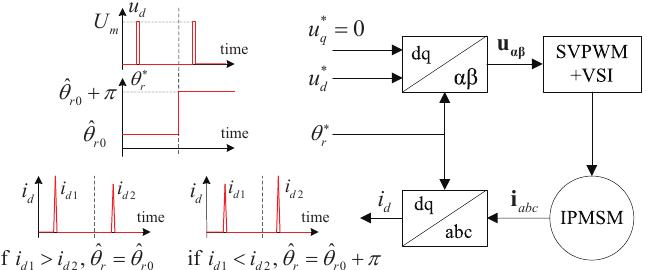
Figure 4. Voltage pulse injection for detecting rotor polarity based on saturation. Two identical voltage pulse vectors are imposed on the of ˆ θ r 0 and ˆ θ r 0 + π directions, where ˆ θ r 0 is the rotor position estimated by the HFI method. These two voltage pulses cause two current pulse responses. If the direction of voltage pulse vector is the same as the rotor PM flux linkage, L d decreases due to the core saturation. Otherwise, if the direction of voltage pulse vector is opposite to that of the rotor PM flux linkage, L d is approximately constant, and the corresponding current pulse vector, which has the higher amplitude, points to the real N